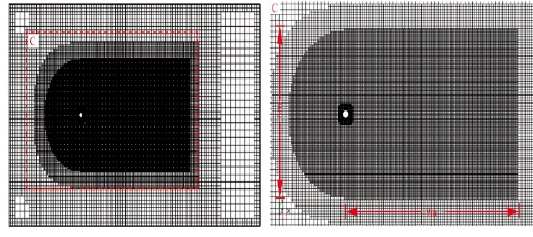
Figure 8. Computing the domain grid of the light pole.